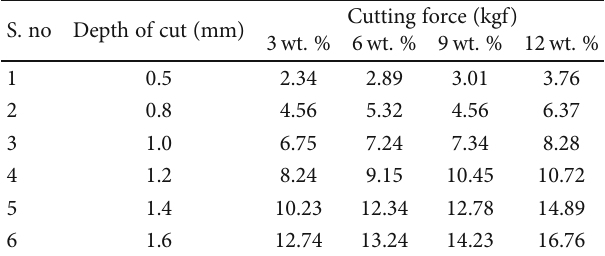
Table 3.Wear test experiments under the in fl uence of 3.0